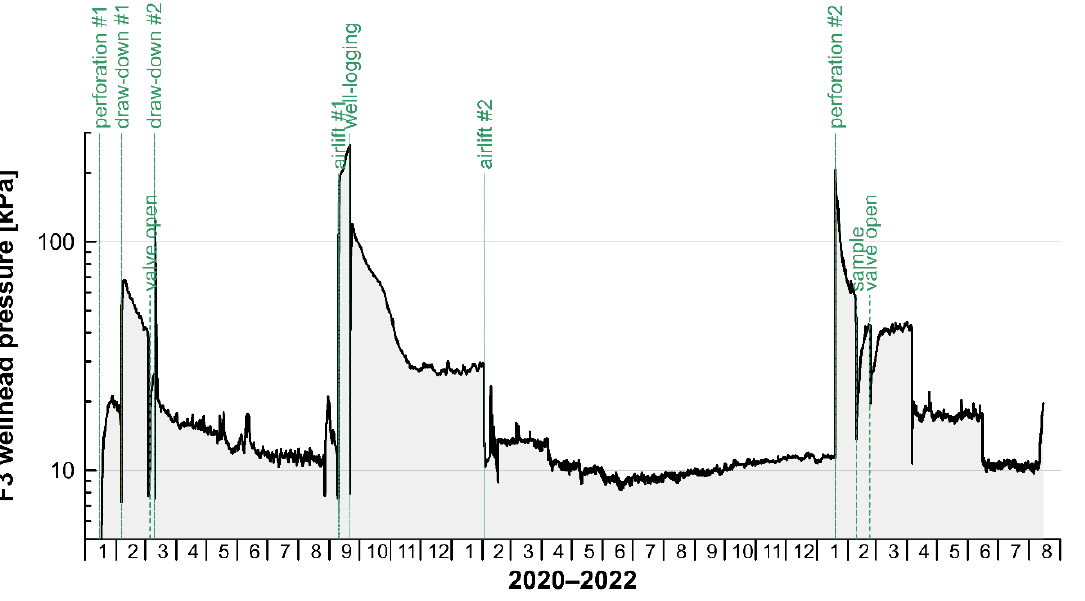
Figure 9. Wellhead pressure at borehole F3 from January 2020 to August 2022. Vertical dashed lines indicate the time of various hydraulic experiments.